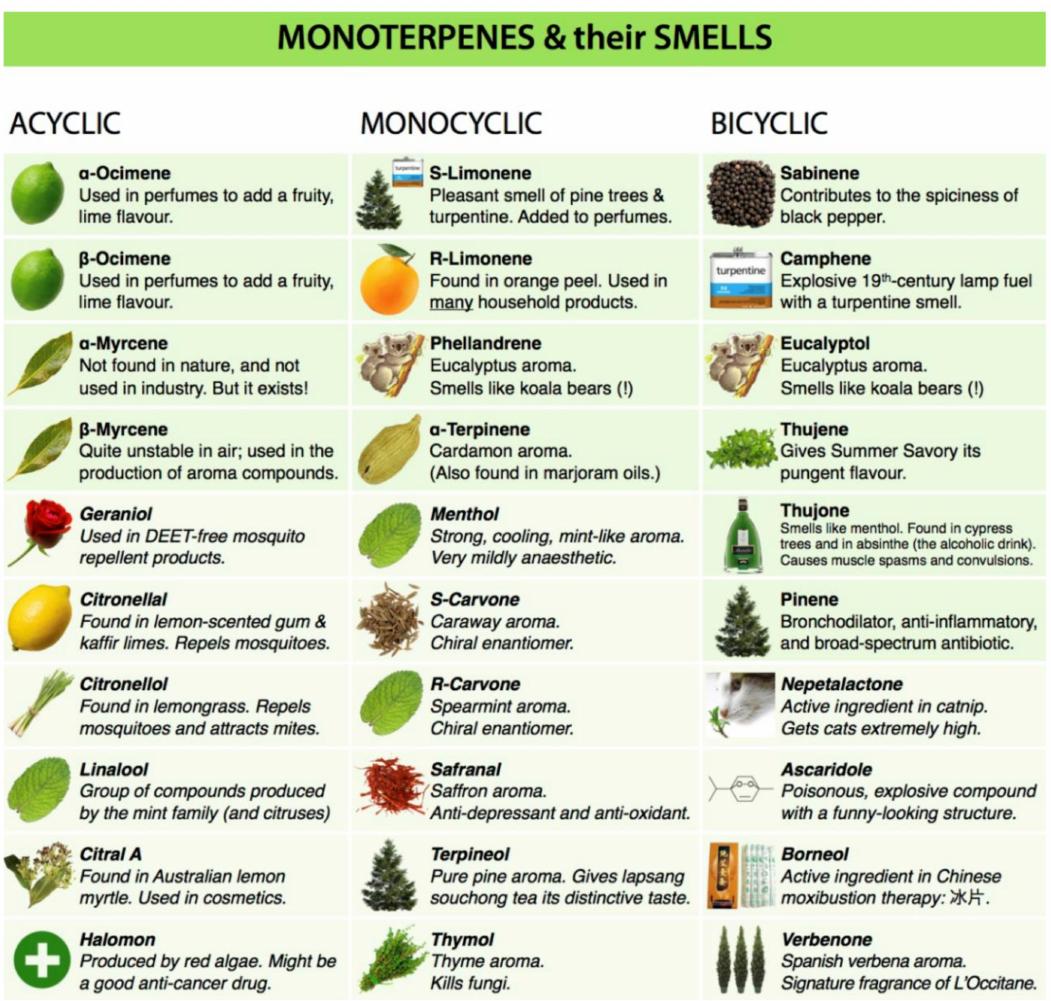
Figure 14. Meet the terpenes: a visual introduction of their uses in aroma and fragrances. Reproduced from https: // www.grozine.com / 2017 / 01 / 05 / terpenes, accessed on March